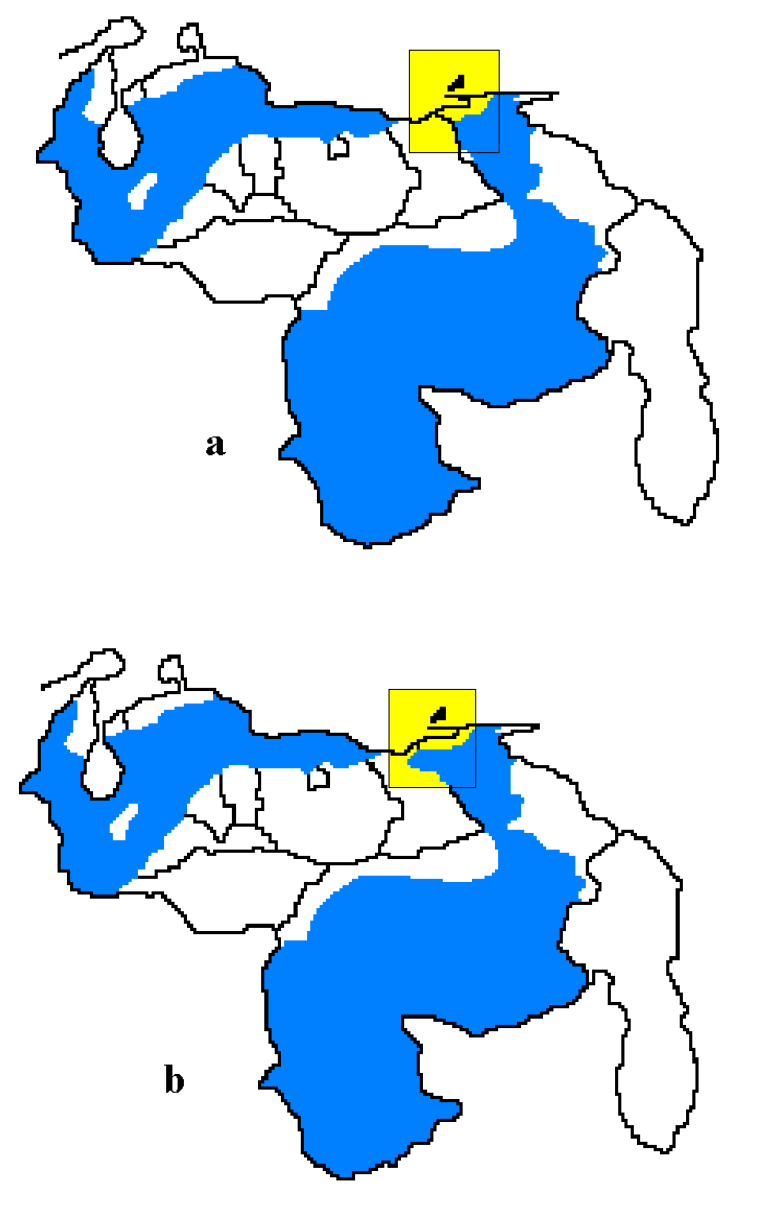
Figure 9 . a. Distribution of scorpions of Tityus genus in Venezuela according to González-Sponga (6) and De Sousa et al. (4). b. New distribution for Tityus in Venezuela (including part of the northeast of Anzoátegui